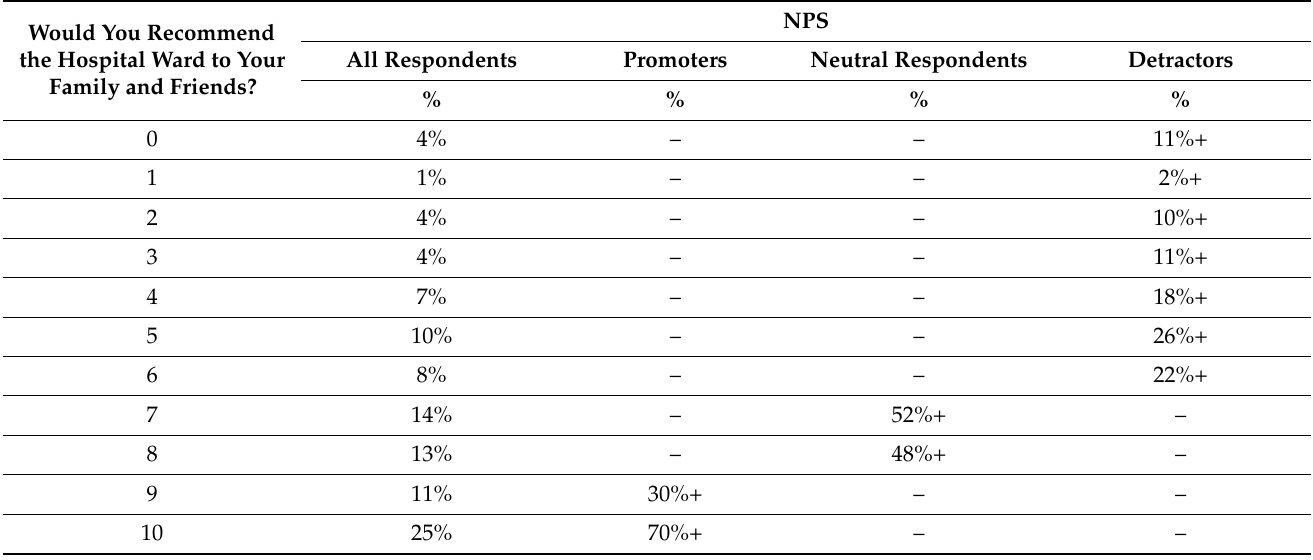
Table 1. Analysis of patients’ recommendations of a hospital/hospital ward to family and friends.